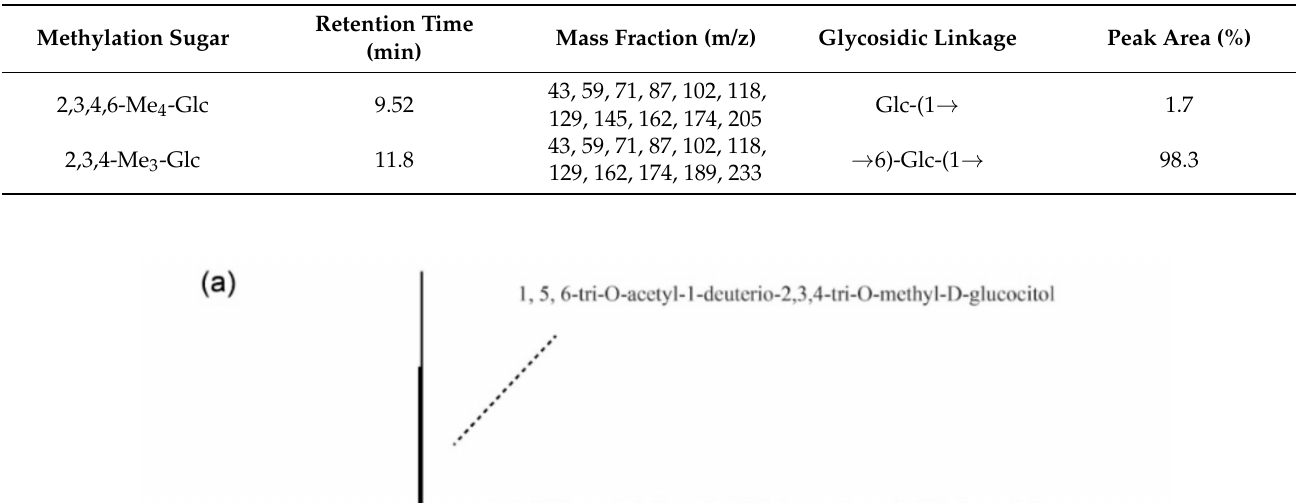
Table 3. Glycosidic linkage analysis of the most immunostimulating polysaccharide (MPF2) from A. hemibapha subspecies javanica .